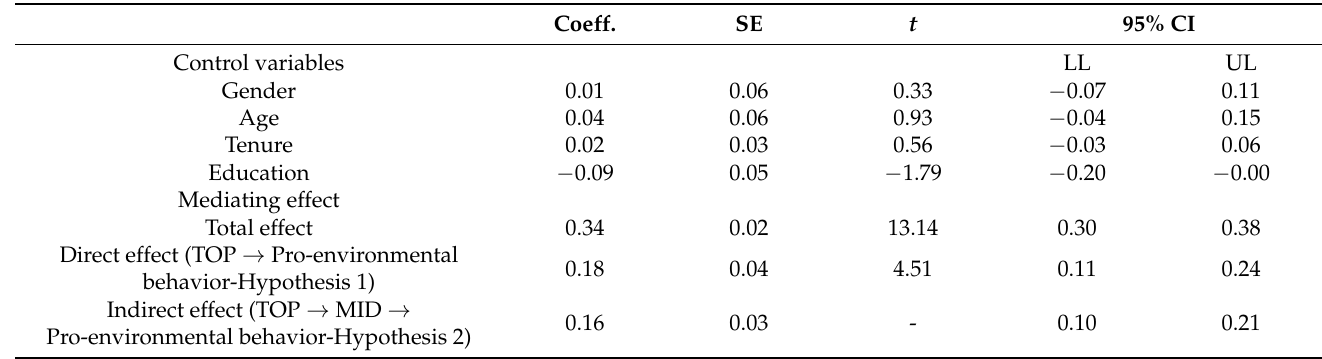
Table 4. Results for Hypothesis 1 and 2.